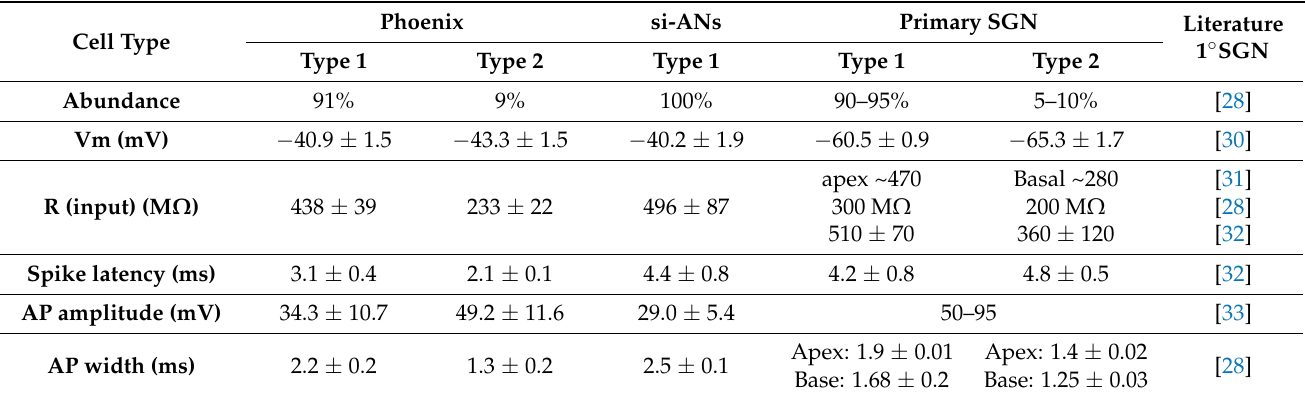
Table 1. Comparison of electrophysiological properties of phoenix- and Si-AN-derived SGN-like neurons (experimental data) and primary SGNs (values from the literature as